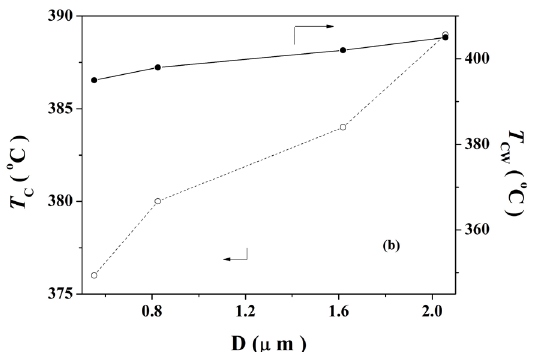
Figure 6. Plot of 1/ε vs . T for the PZT52/48 ceramics around T at 1 MHz.